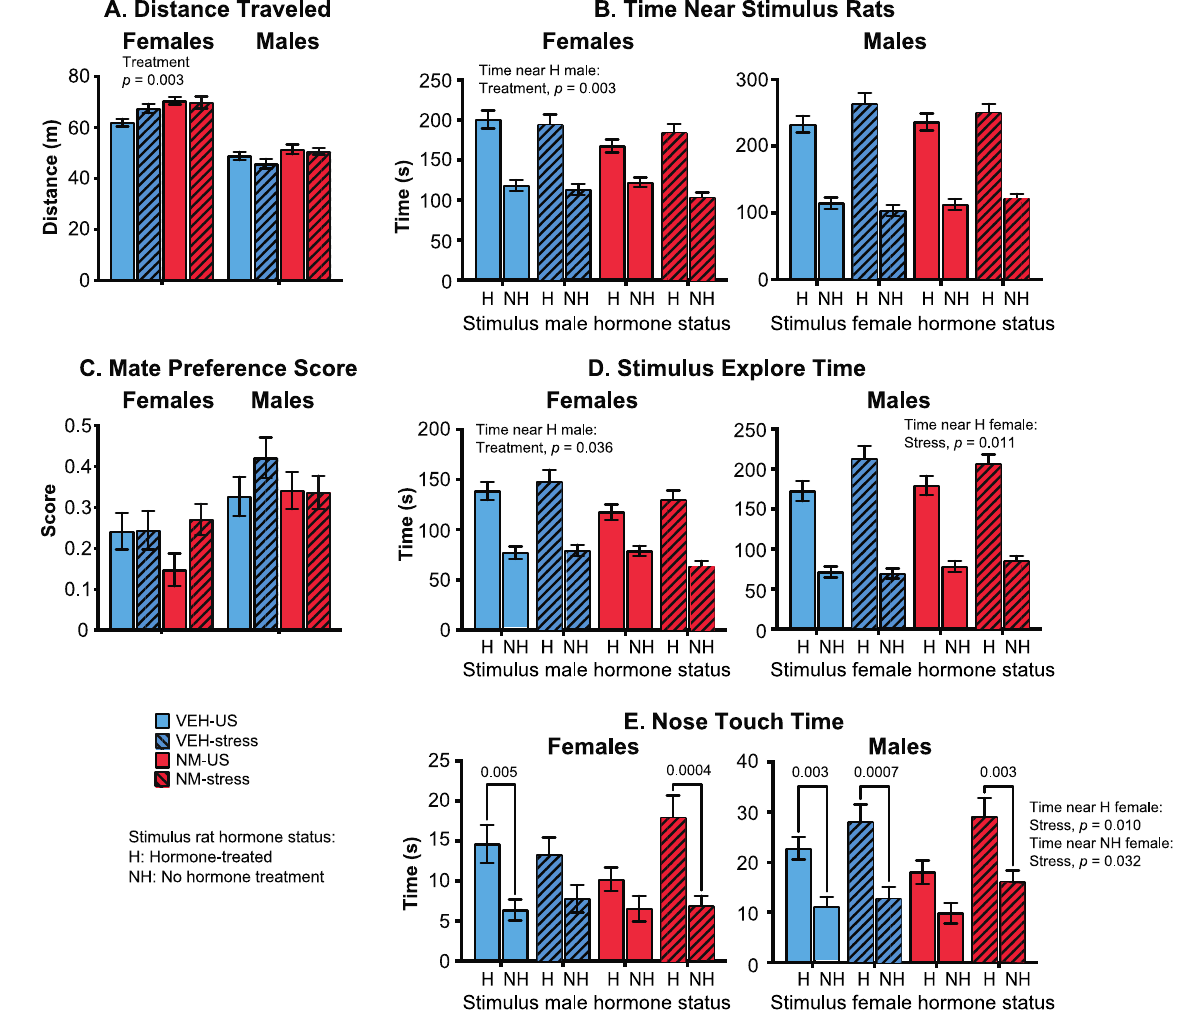
Figure 6. Effects of prenatal NeuroMix and/or stress in adolescence on behaviors in the Mate preference test in which rats were offered a choice between two opposite-sex conspecifics, both castrated, with one hormone-treated (H) and the other not given hormone (NH). ( A ) Distance traveled was increased by treatment in females. ( B ) Time spent near the stimulus rats was affected only in females, with time spent near the hormone-treated male significantly decreased by NeuroMix compared to vehicle. ( C ) Mate preference score was unaffected. ( D ) Stimulus explore time, defined as time spent engaging with the stimulus rat, was affected in females, with time exploring near the hormone-treated male decreased by NeuroMix compared to vehicle. In males, stress increased stimulus explore time spent near the hormone-treated stimulus female. ( E ) Time spent nose touching was affected in both sexes. Females in the vehicle–unstressed and NeuroMix–Stressed groups, showed the expected preference for a hormone over a no-hormone male, an effect that was not seen in the vehicle–stress or NeuroMix–unstressed females. In males, the expected preference for hormone- over no-hormone-treated females was found in all groups except the NeuroMix–unstressed group. In addition, in males, stress increased time near both the hormone- and no-hormone-treated females. Sample sizes for vehicle–unstressed, vehicle–stress, NeuroMix–unstressed, and NeuroMix–stressed females: n = 27, 19, 28 and 22; for males, n = 28, 20, 30, and 22. VEH = vehicle; NM = NeuroMix; US = unstressed.